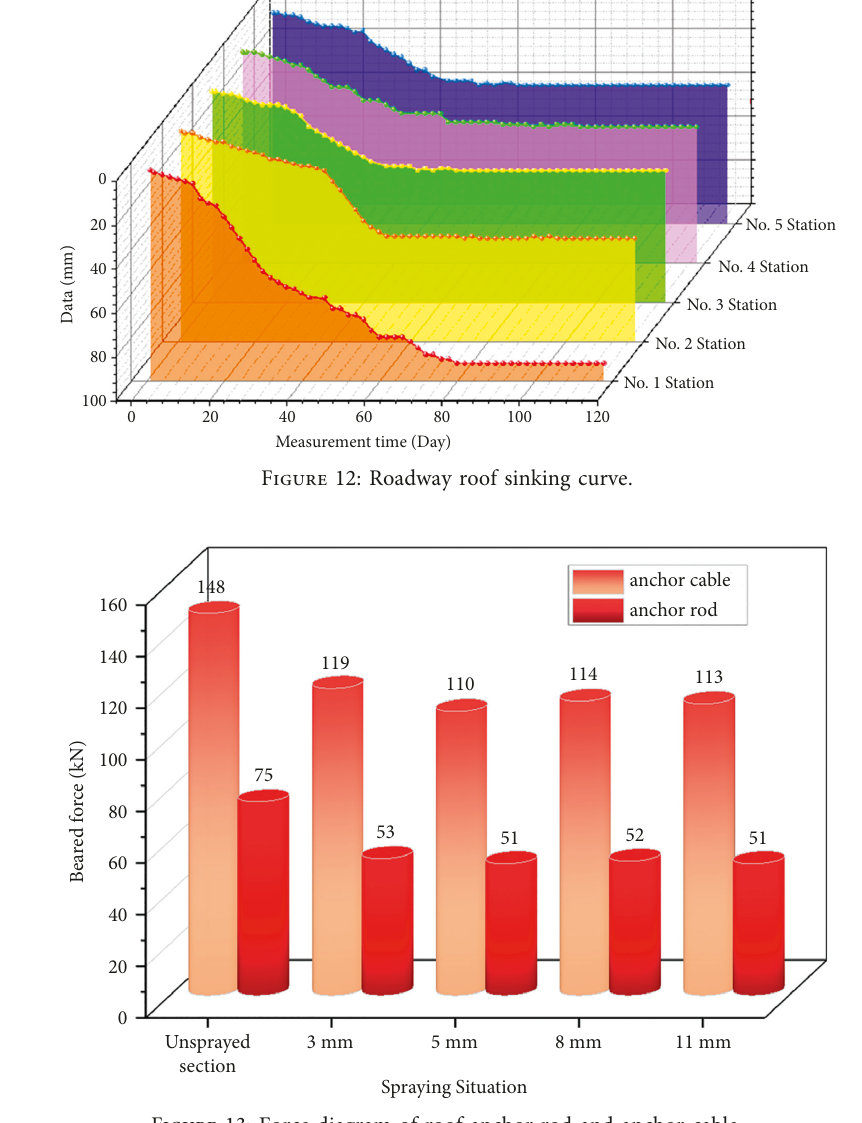
Figure 13: Force diagram of roof anchor rod and anchor cable.